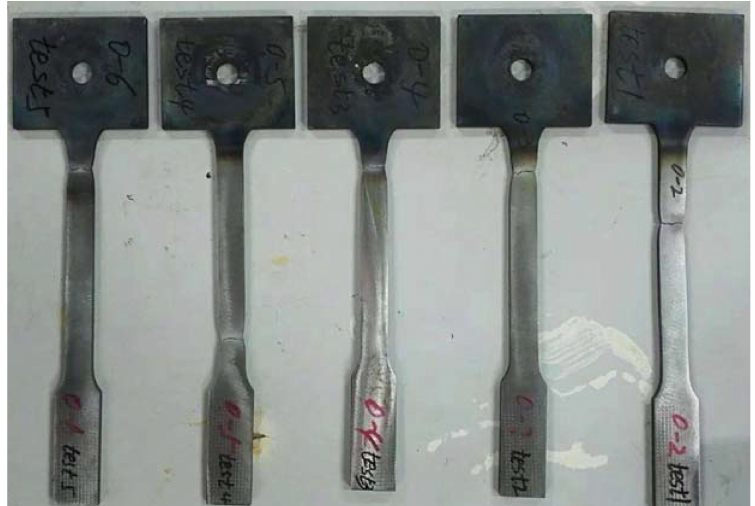
Figure 3. Failure of the quasi-static test